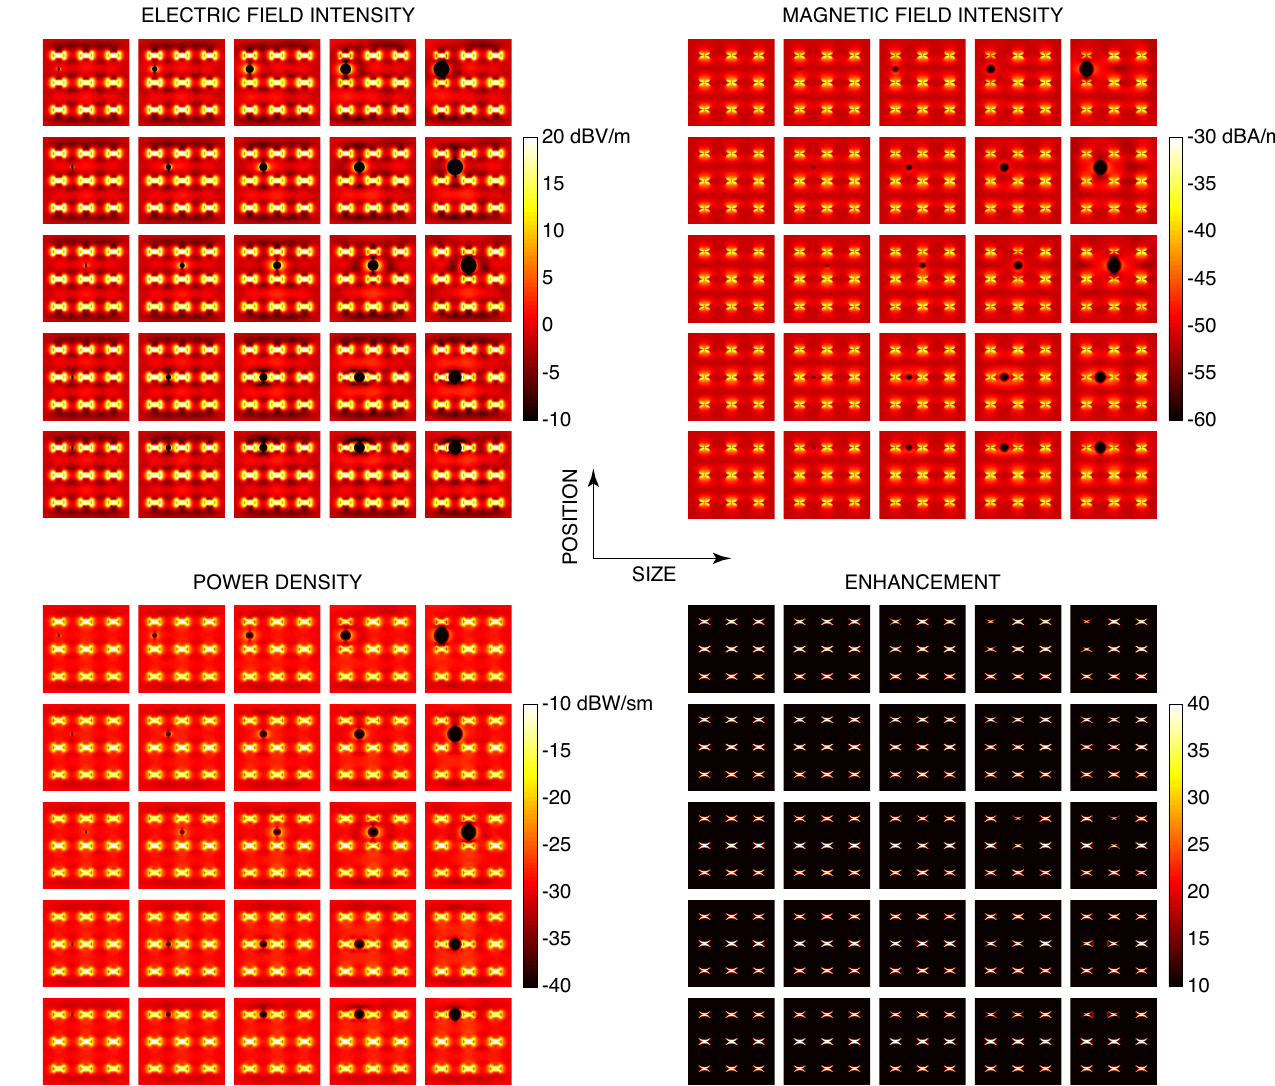
Figure 5: Near-zone characteristics of an array of 3 × 3 nanoantennas when Ag particles with different sizes are located in the array plane. The periodicity of the array is 500 nm, while the particle diameter changes from 50 nm to 300 nm (for the first three locations) or from 50 nm to 250 nm (for the last two